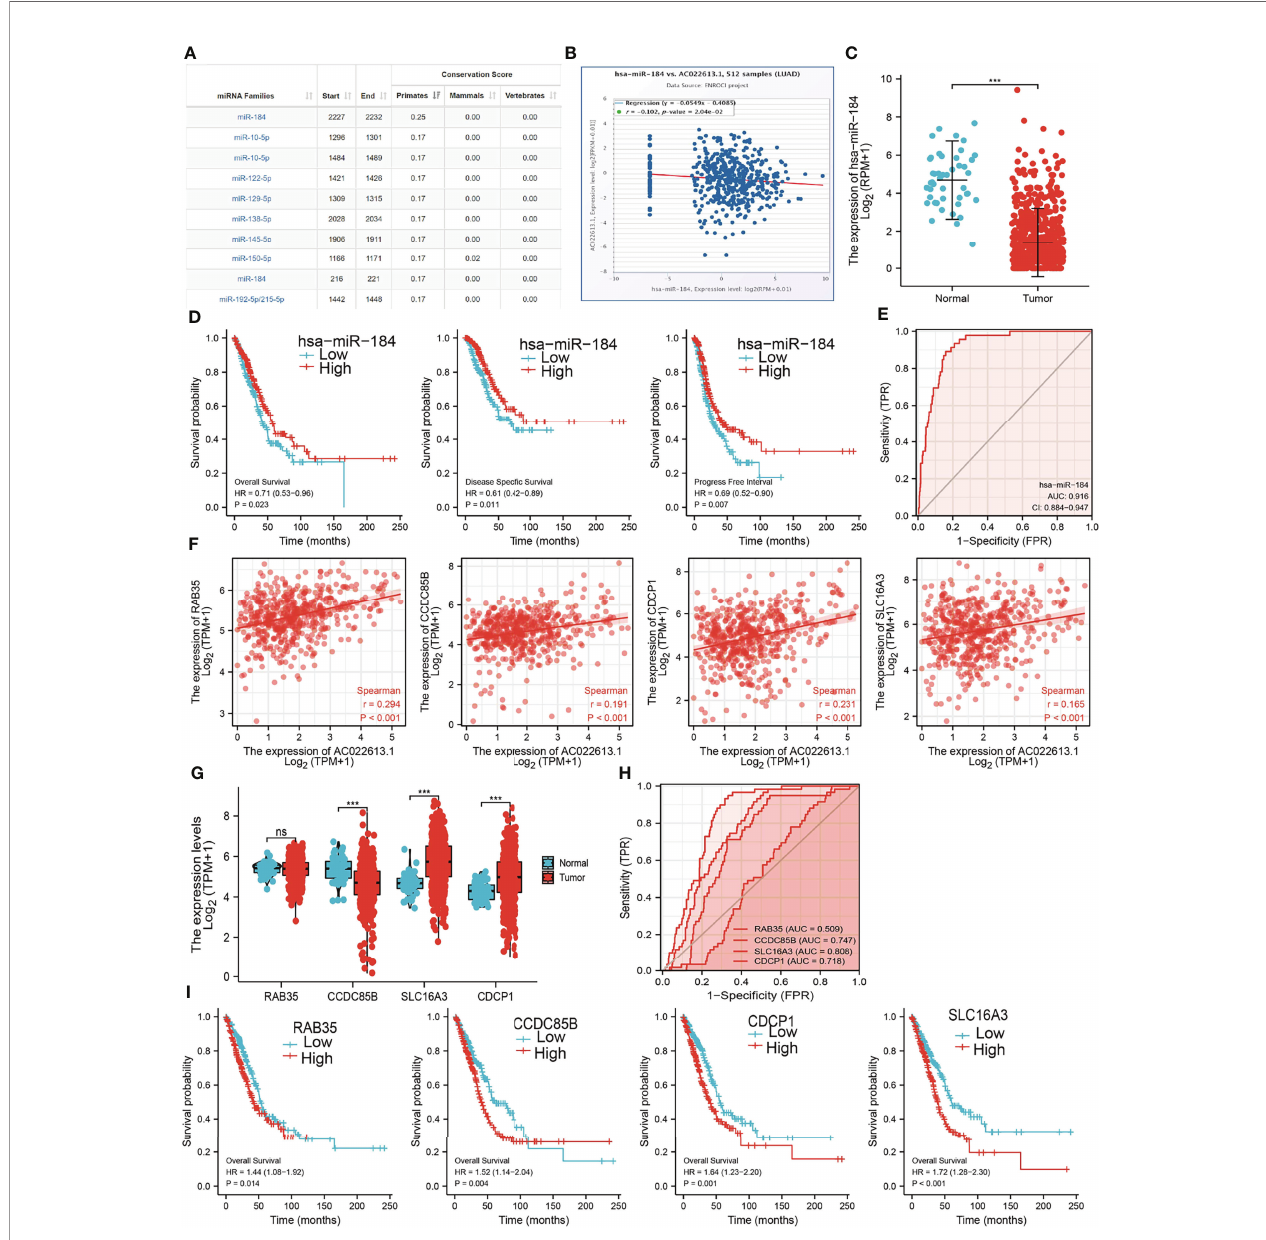
FIGURE 9 | Analysis of the potential ceRNA network of of LCIIAR (A) The potential miRNAs of LCIIAR was determined by Anbolnc2 database. (B) Correlations between LCIIARexpression and miR-184 in LUAD (C) The expression level of miR-184 in LUAD (D) OS, DSS and PFS of miR-184 in LUAD. (E) ROC curve of miR-184 in LUAD. (F) Correlations between LCIIAR expression and RAB35, CCDC85B, SLC16A3, and CDCP1 in LUAD. (G) The RNA level of RAB35, CCDC85B, SLC16A3, and CDCP1 in LUAD. (H) The ROC curve of RAB35, CCDC85B, SLC16A3, and CDCP1 in LUAD. (I) OS of RAB35, CCDC85B, SLC16A3, and CDCP1 in LUAD, NS: p > 0.05, ***p <